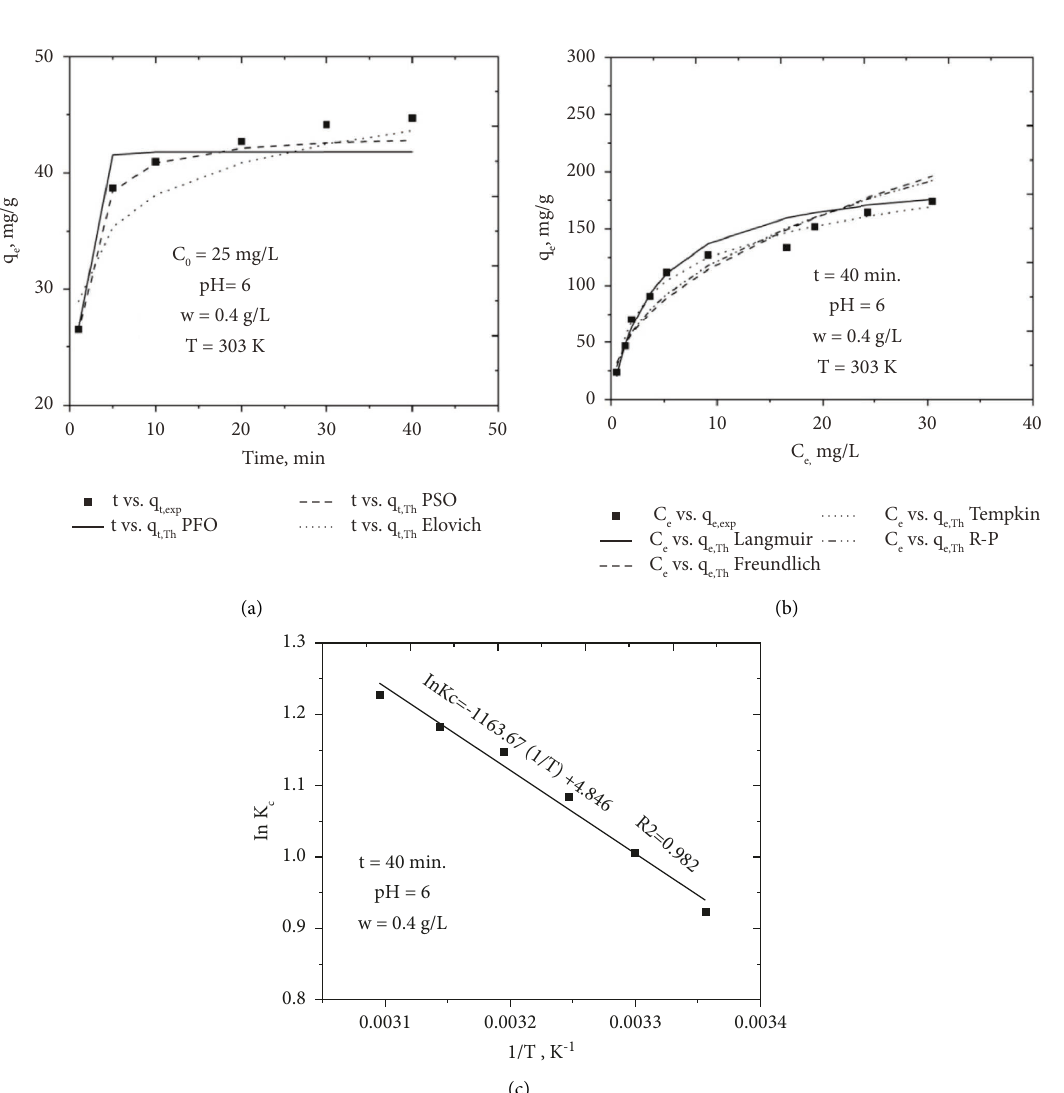
Figure 8: MSE vs. the number of epochs in the hidden layer.